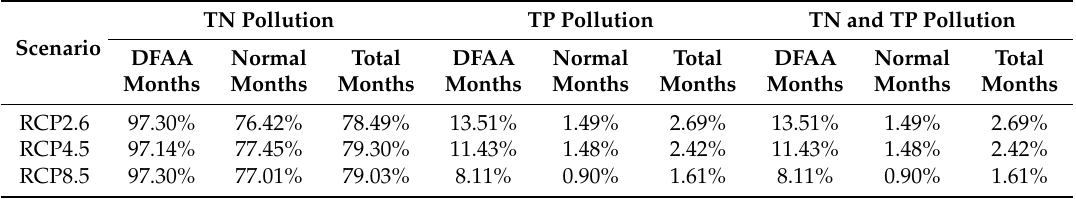
Table 7. The incidence of water pollution (%) in Class III under different months.